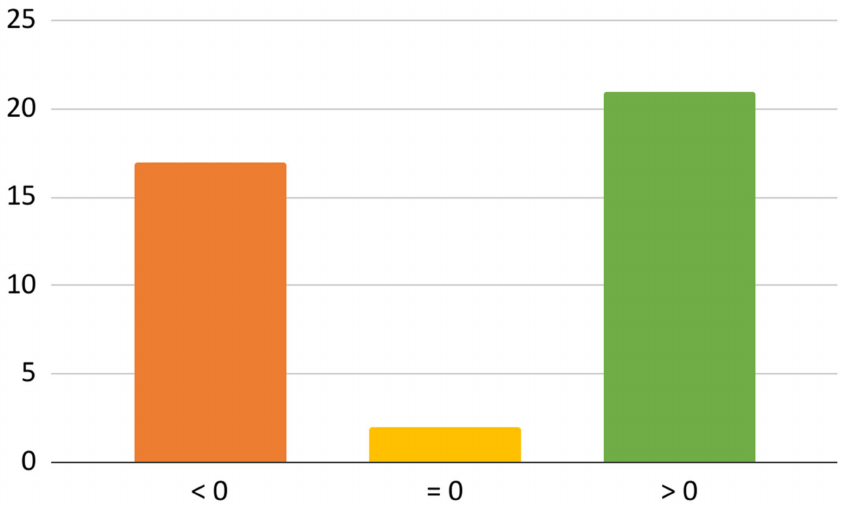
Figure A4. The number of patients who decreased the extent of maximum mouth opening (<0), the extent of maximum mouth opening did not change (=0), and the extent increased (<0) based on differences in treatment outcomes. Table A1. Table of correlation between the analyzed variables. Description in the